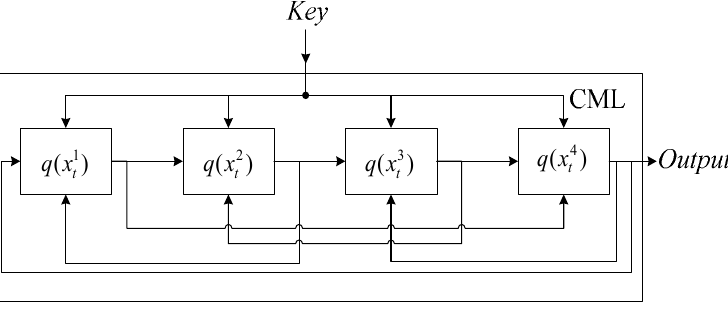
Figure 4. The simulation result of the original four stage CML based on the logistic map. In this subsection, we present the schemes of the original four stage CML based on the tent map. The original coupled map lattice is listed as Equation (3) and in our implementation, N = 4. Figure 5 shows the structure of the original four stage CML based on the tent map. The q ( x ) is the chaotic tent map, Key is the input, and the final throughput is Output .